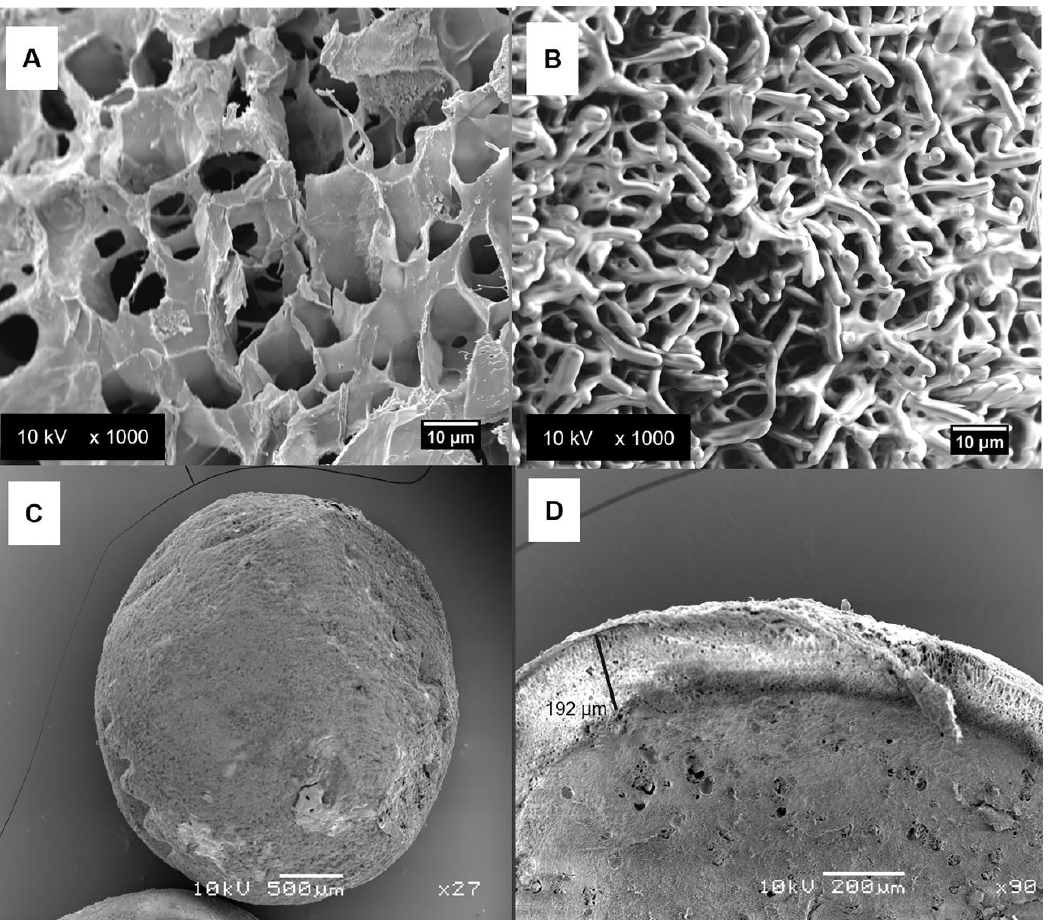
Figure 5. FE-SEM surface analyses of CHT/INDO ( A ) bead, CHT/NLC-INDO ( B , C ) and a cross-section of XAN@CHT/NLC-INDO ( D ) nanobeads. The figure emphasizes the thickness of xanthan coating, calculated by ImageJ software ( D ). The magnifications used were as follows: 1000× for ( A , B ), 27× for ( C ) and 90× for ( D ) images, operated at 10 kV. NOTE: CHT/INDO= chitosan bead loading INDO 2% ( w / v ), CHT/NLC-INDO= nanobead loading indomethacin 2% ( w / v ), XAN@CHT/NLC- INDO = xanthan-coated CHT/NLC-INDO